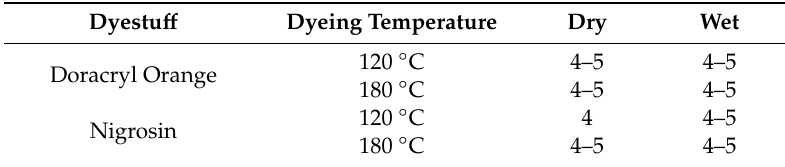
Table 5. Fastness to rubbing of amorphous m-aramid fabrics dyed in EMIM-EtSO 4 with Doracryl Orange and Nigrosin at 120 ◦ C and 180 ◦ C,